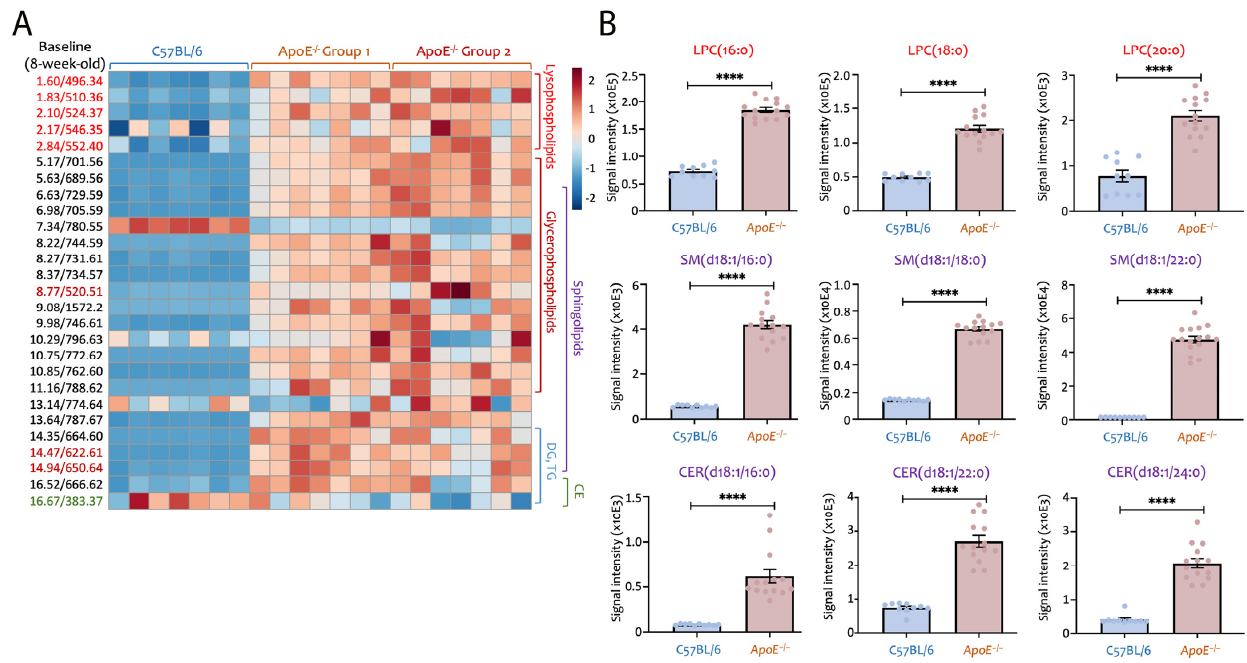
Figure A1. ApoE − / − mice had altered plasma lipid patterns at 8 weeks of age, with higher levels of lysophosphatidylcholine (LPC), sphingomyelin (SM), and ceramide (CER). Data was presented in (A) a heatmap and (B) bar plots with dots. Similar to Figure 2, but the bar plots here combined data from the two apoE − / − groups and was in signal intensity. The LPC(16:0) and LPC(18:0) were the most abundant LPC species, whereas the SM(d18:1/22:0) was the most dominant sphingolipid species in the 8-week-old mice. The data are presented in signal intensity. **** p < 0.0001. Abbreviations: apoE − / − : apolipoprotein E knockout; LPC: lysophosphatidylcholine; SM: sphingomyelin; CER: ceramide.